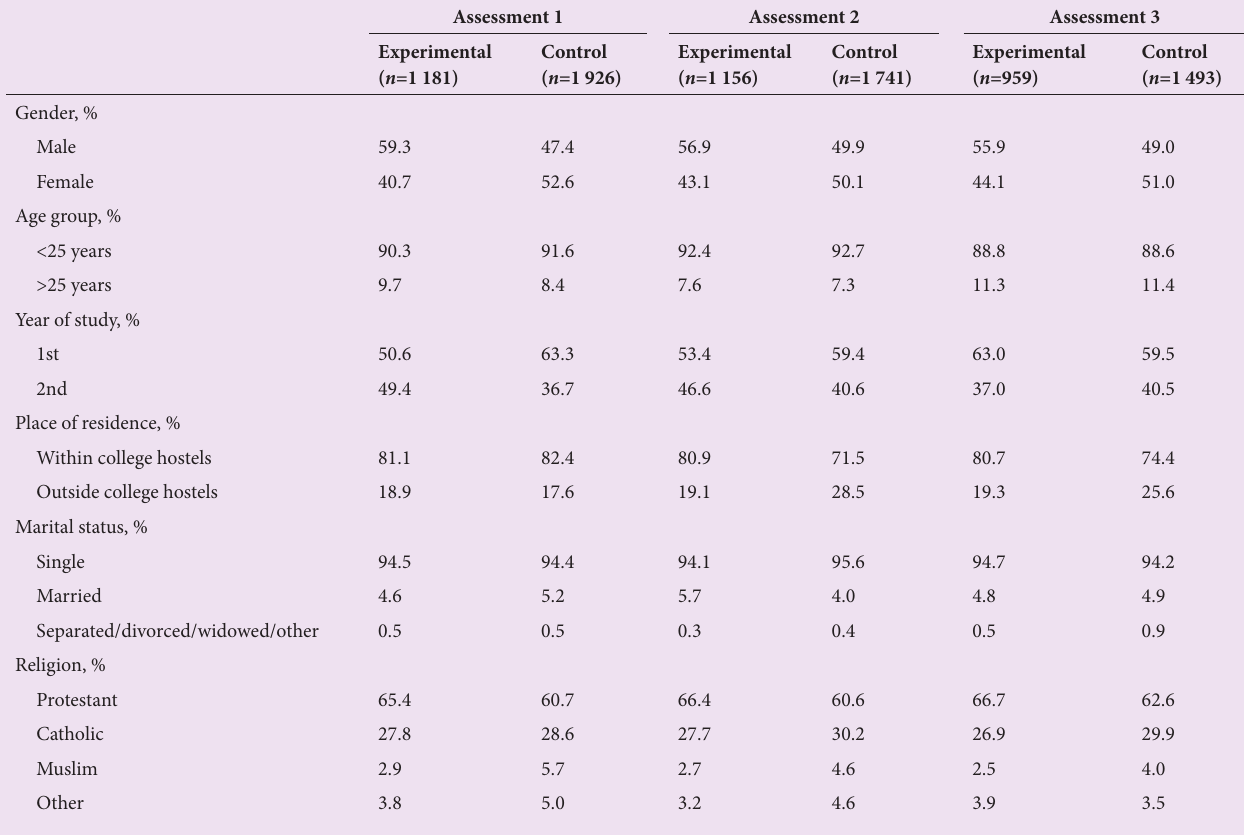
Table 1. Socio-demographic background characteristics of the study